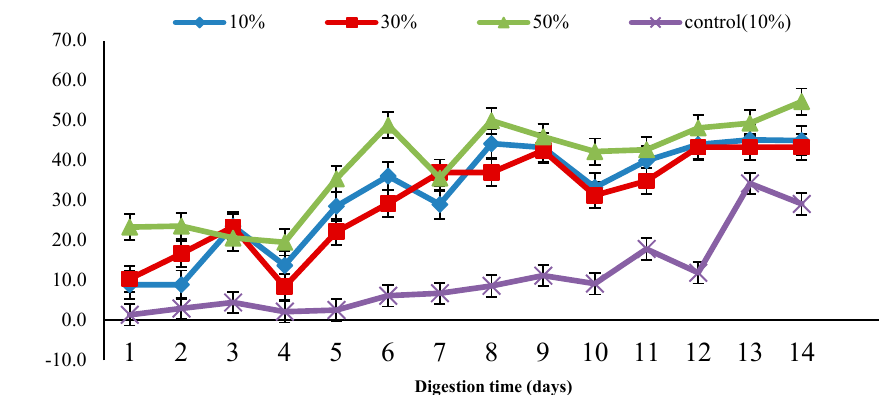
Figure 13. Percentage of TVS reduction (%) in the digesters with different inoculum-to-feed ratios with digestion time of 14 days.